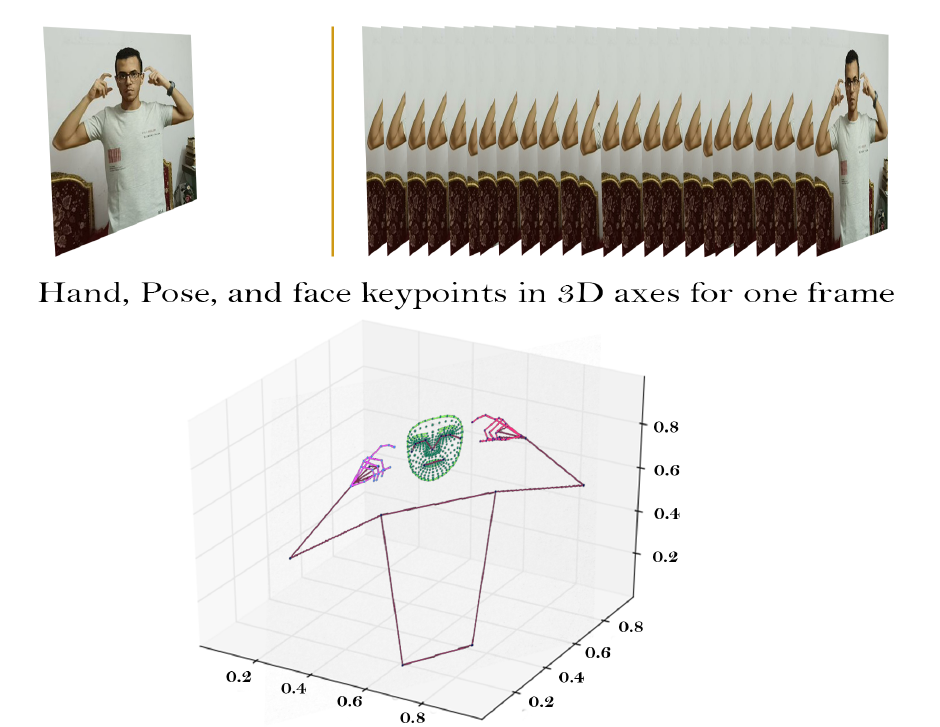
Figure 1. The sequence of frames and keypoints of hands and body in 3D space.